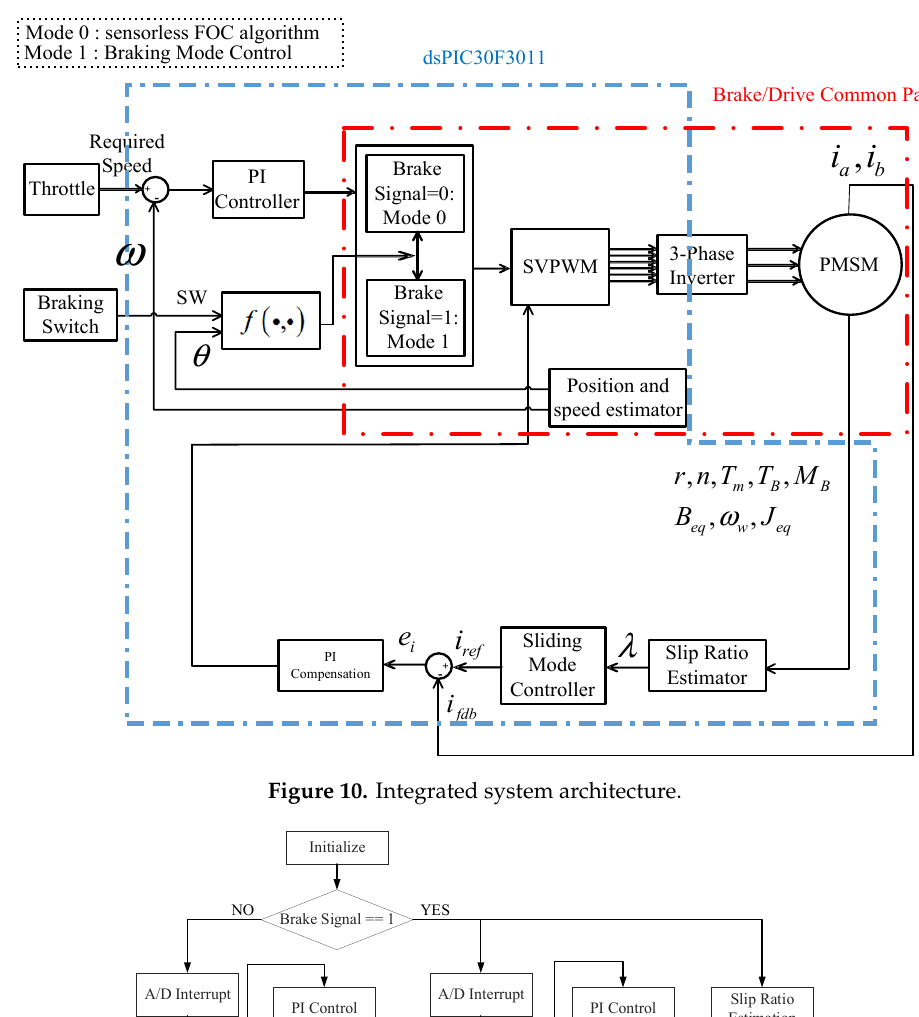
Figure 10. Integrated system architecture.